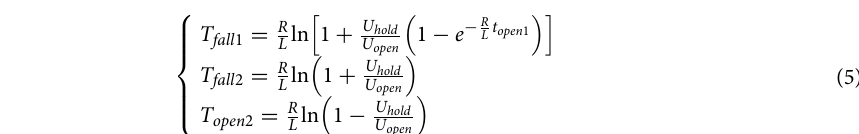
Figure 3. AMEsim model for the